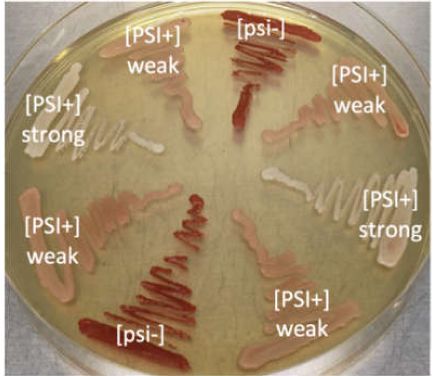
Figure 1. Phenotype of ADE1 mutants in the absence or presence of different variants of [PSI] prions in an synthetic complete (SC) medium. White—cells containing strong [PSI+] prion, pink—cells containing weak [PSI+] prion, and red—cells without prion ([psi −